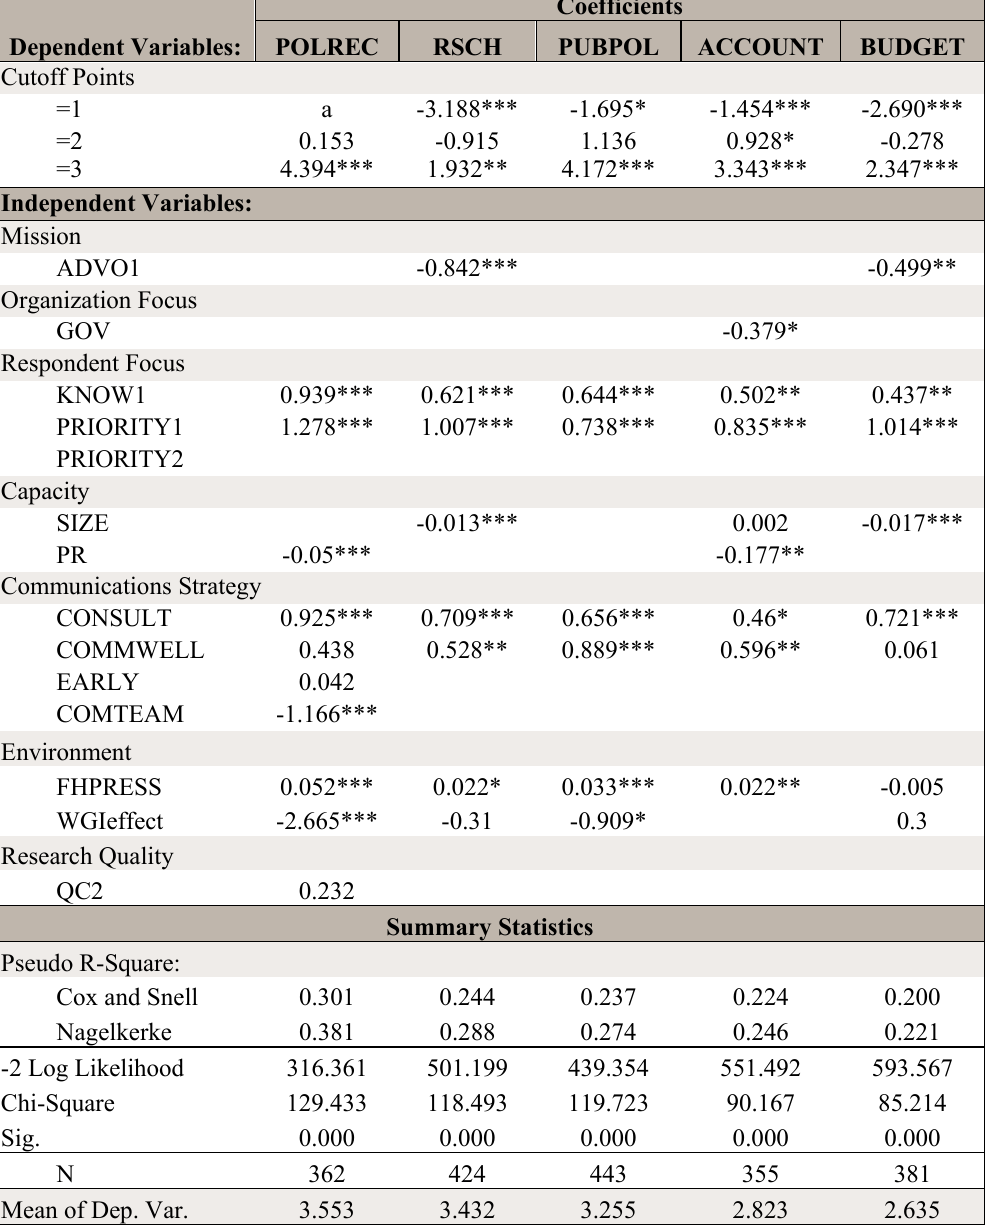
Table 4. Pooled Country Regression